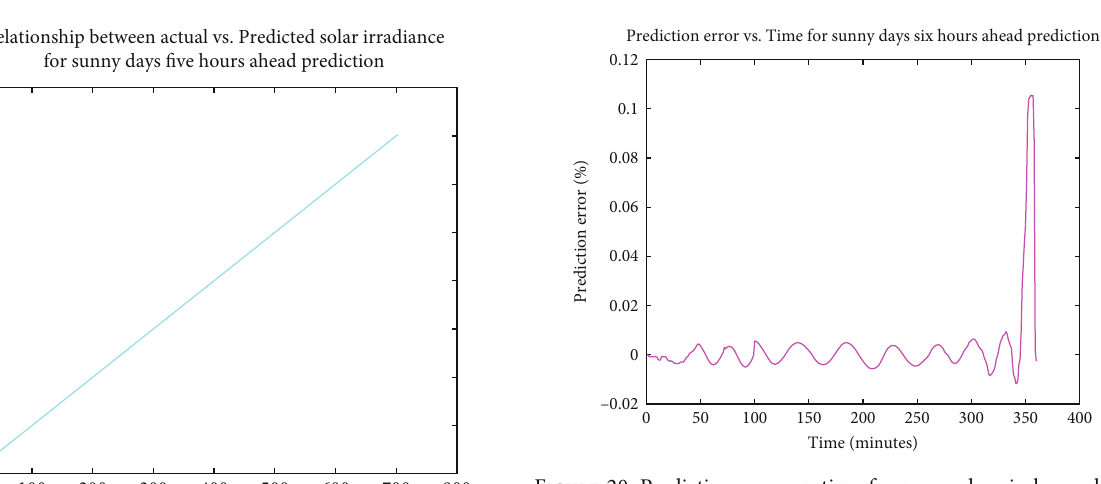
Figure 20: Prediction error vs. time for sunny day six-hour-ahead prediction.